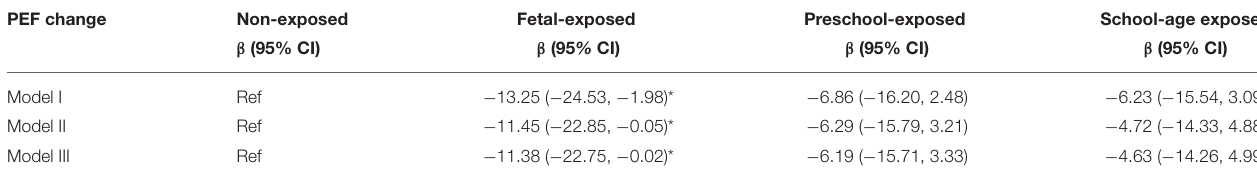
TABLE 3 | Association between early-life exposure to Chinese famine and PEF indicator in adulthood.